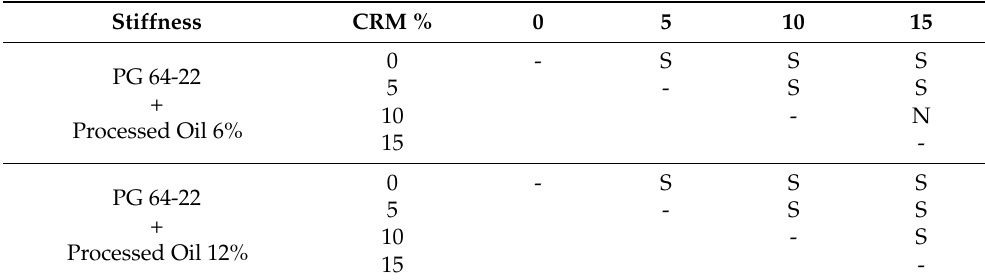
Table 10. Statistical analysis of stiffness for RTFO + PAV aged PG 64-22 binder modified with 6%